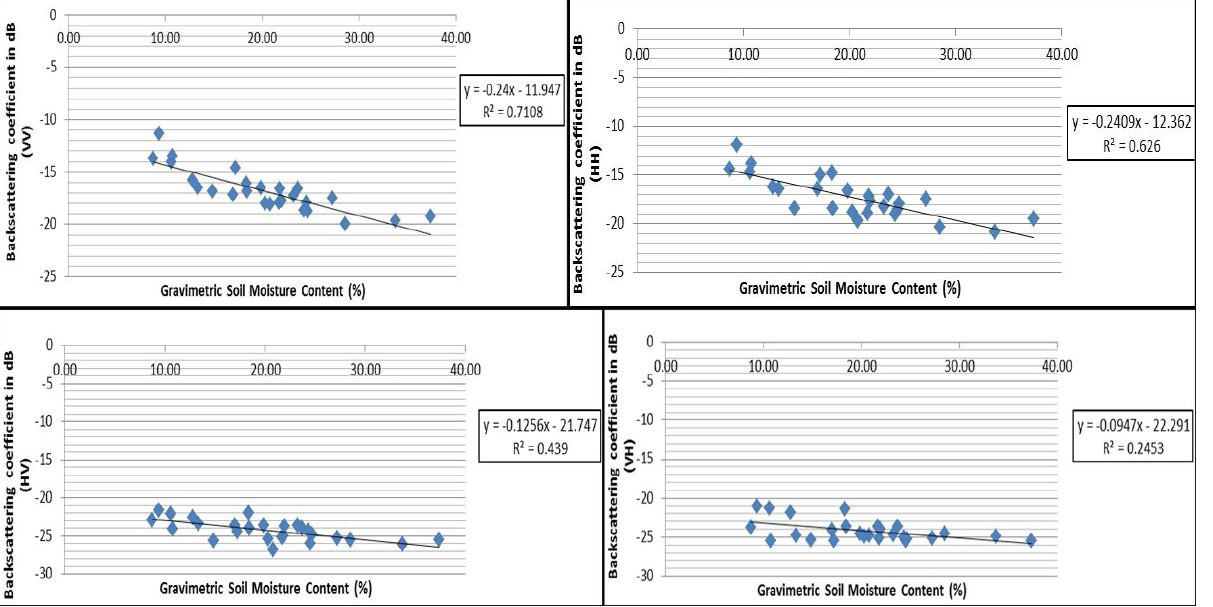
Figure 3. The results of the linear regression